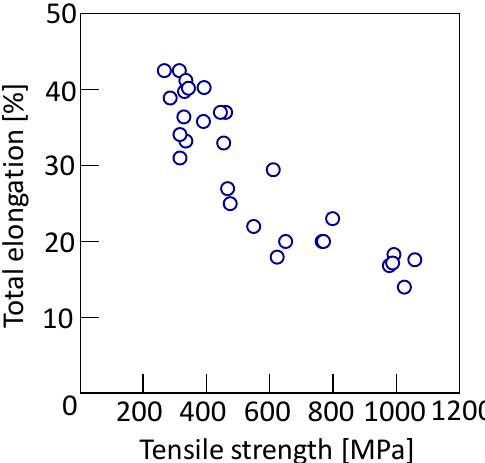
Figure 1. Relationship between total elongation and tensile strength for various commercial steel sheets.